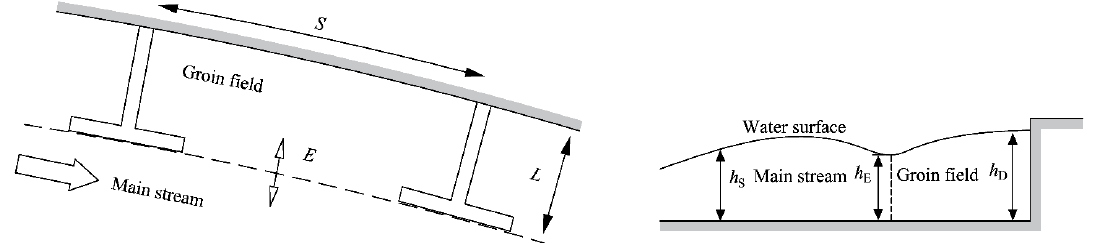
Figure 8. Exchange model between groin field and main stream.